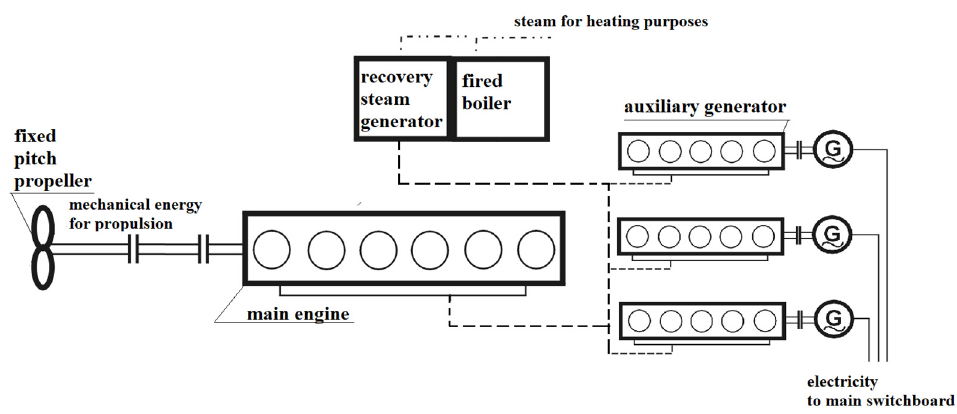
Figure 1. Direct propulsion system with 3 auxiliary generators and steam generators (own drawing).